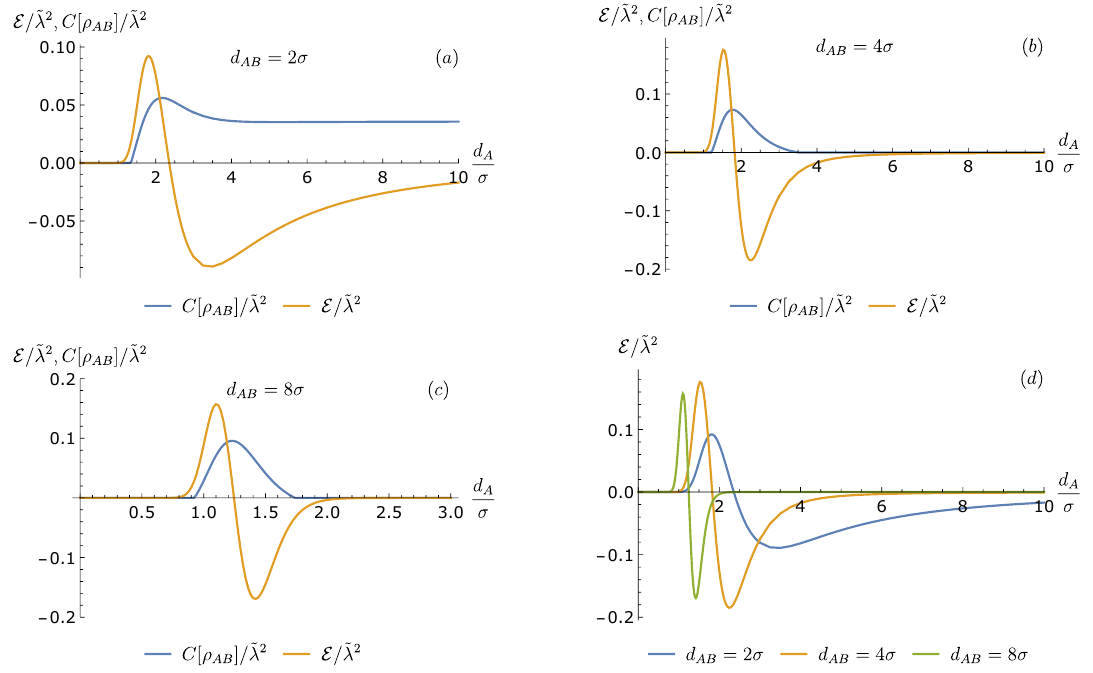
Figure 8 . Concurrence C [ (cid:26) AB ] and signalling estimator E as a function of proper distance of Alice’s detector from the horizon for various detector separations d AB . Here (cid:10) (cid:27) = 2, M=(cid:27) = 1 = 2. The concurrence is computed using the Unruh vacuum case as a reference. (a) d AB = 2 (cid:27) / (b) d AB = 4 (cid:27) . (c) d AB = 8 (cid:27) . (d) the signalling estimators for various d AB . Note that the dominant part of E is increasingly concentrated to a small region where entanglement can be extracted by the detectors as they become more spacelike